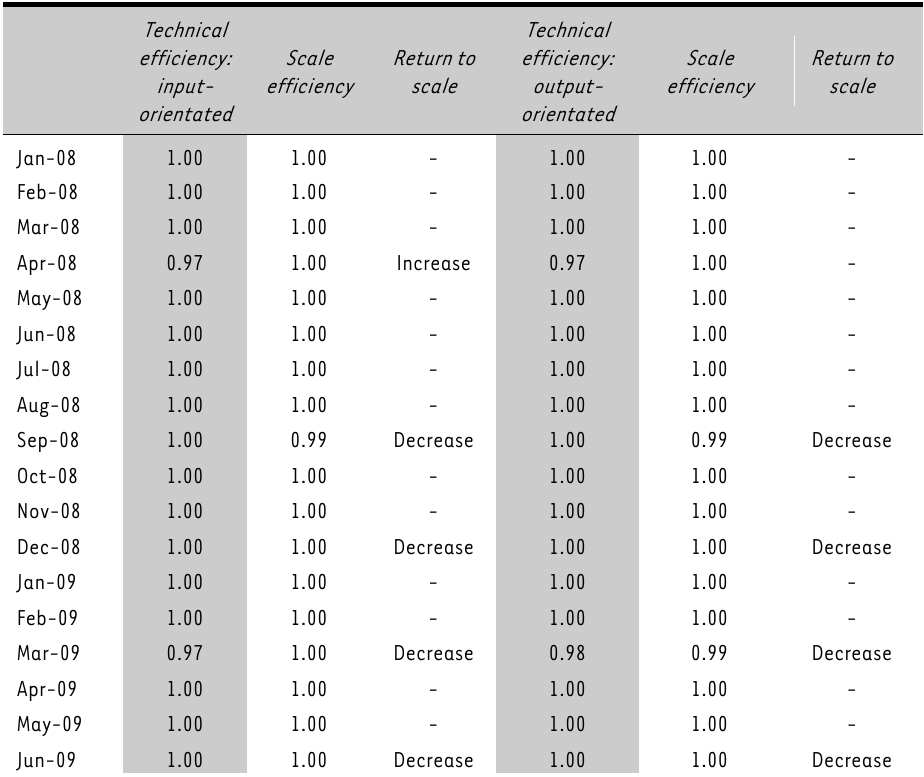
TABLE 15: Efficiency estimates: Standard